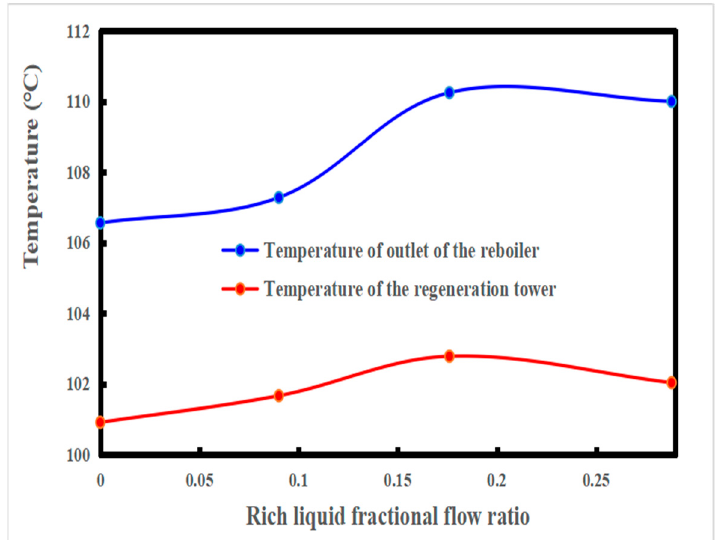
Figure 8. Effect of the rich liquid fractional flow ratio on the temperature in the regeneration tower and the outlet of the heat exchanger. The steam consumption is 60 kg/h, liquid–gas ratio is 1.82 L/m 3 , regeneration pressure is 191 kPa, and interstage cooling temperature is 40 °C.